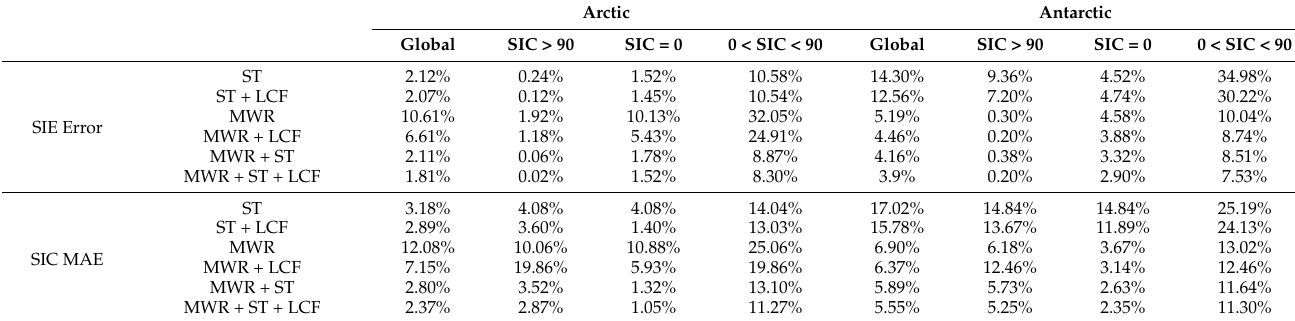
Table 1. MWR NN error with respect to the input variables.